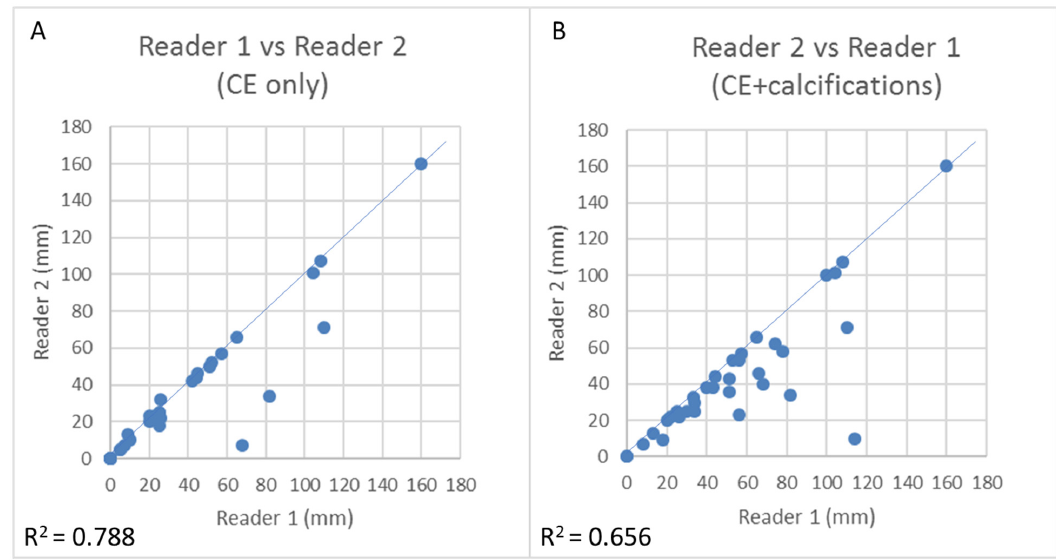
Figure 4. Linear regressions depicting concordance between the two CEM readers when considering CE only ( A ) and CE plus calcifications ( B ) ( n = 36).